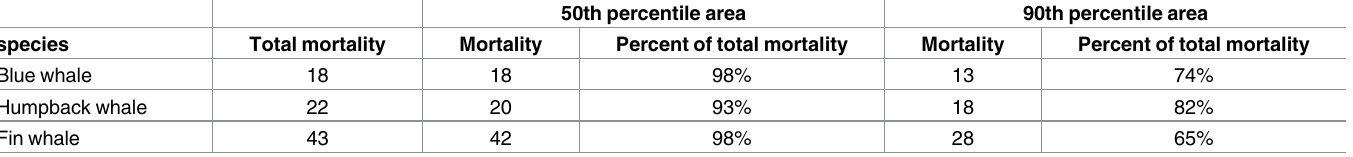
Table 3. Comparison of total mortality and mortality within the 50 th percentile and 90 th percentile areas.